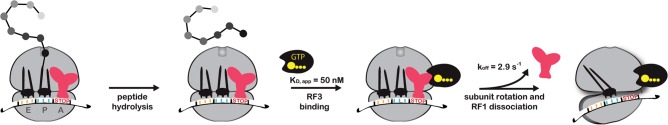
Model for RF3 mechanism of action in translation termination. In this model, following peptide release, with the ribosome in a nonrotated state, RF3:GTP binds the termination complex. The ribosome then undergoes a conformational change to the rotated state, thereby promoting RF1 dissociation.